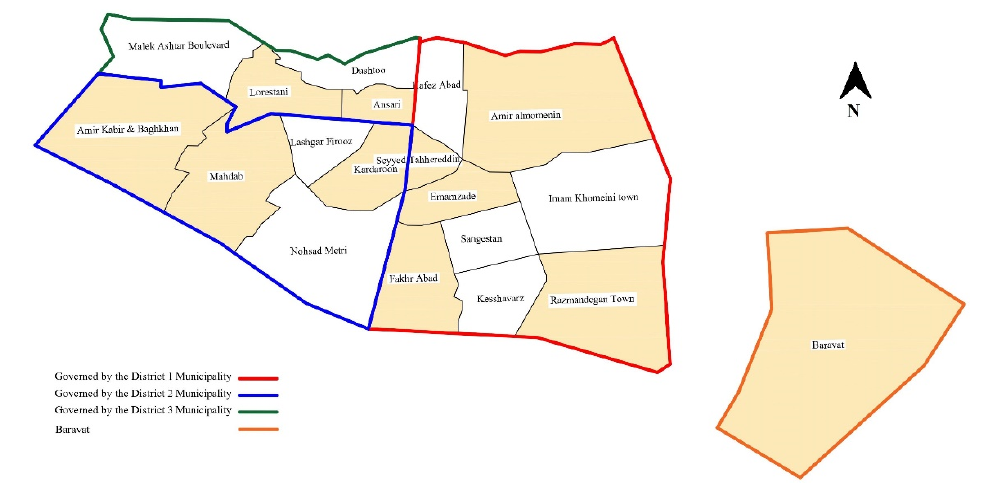
Figure 4. Selected neighborhoods in Bam and Baravat.